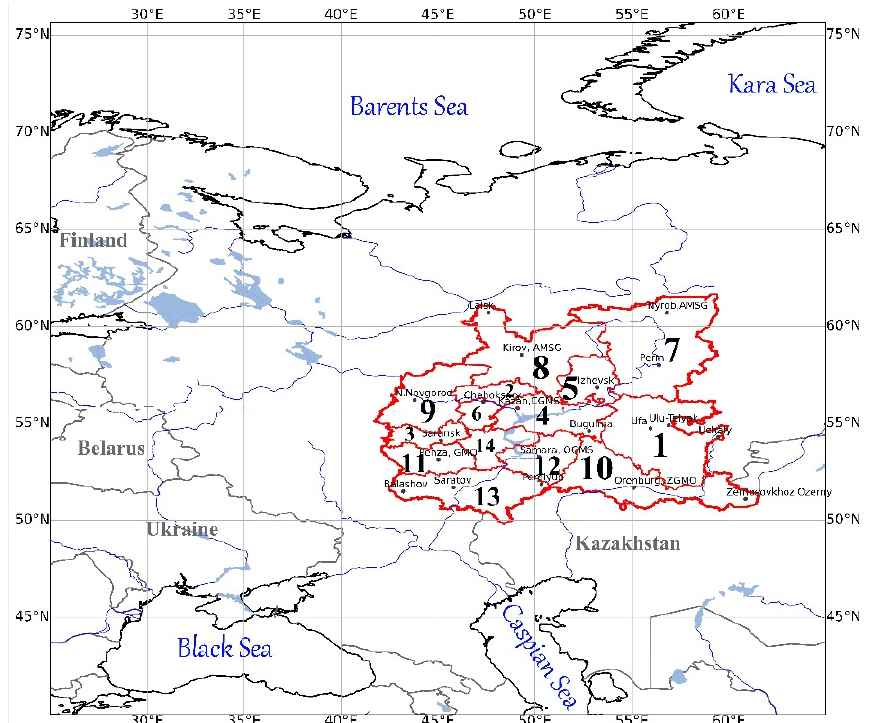
Figure 1. The Volga Federal District and its main (key) meteorological stations analyzed. Administrative regions of the Russian Federation: 1—Republic of Bashkortostan; 2—Mari El Republic; 3—Republic of Mordovia; 4—Republic of Tatarstan; 5—Udmurt Republic; 6—Chuvash Republic; 7—Perm Krai; 8—Kirov Oblast; 9—Nizhny Novgorod Oblast; 10—Orenburg Oblast; 11—Penza Oblast; 12—Samara Oblast; 13—Saratov Oblast; and 14—Ulyanovsk Oblast.